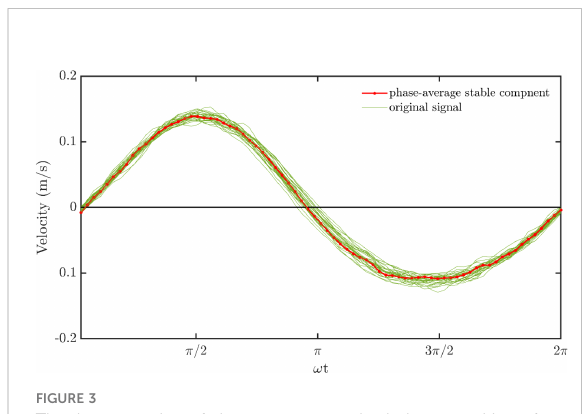
FIGURE 3 The demonstration of phase-average method: decomposition of the velocity into stable components and turbulence